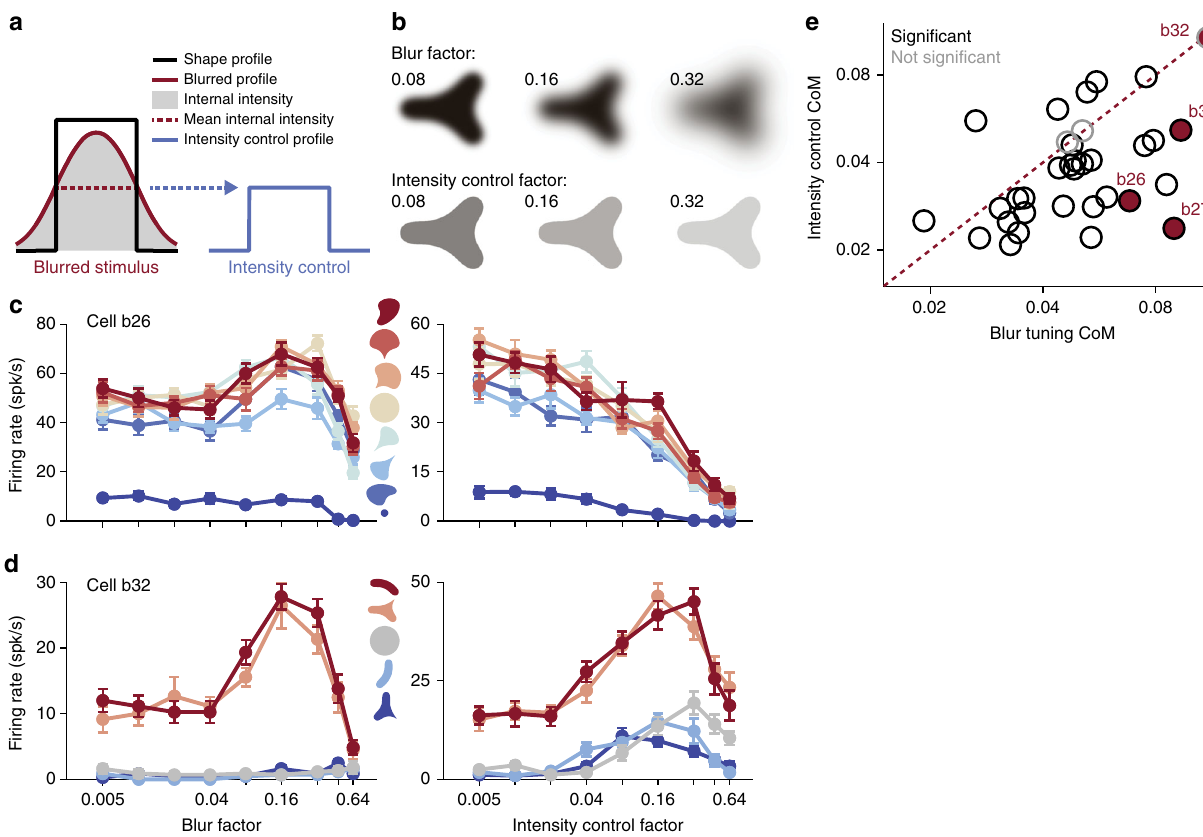
Fig. 5 Stimulus contrast does not explain blur selectivity. a Pro fi le schematic of how a blurred stimulus (red) has a decreased mean foreground intensity relative to a sharp ( β = 0.005) stimulus (black). Low/high values correspond to background/foreground image intensities, respectively. An intensity control is constructed from a sharp shape with an identical mean foreground intensity (blue). b Example blurred stimulus and intensity-matched controls. Stimuli are shown in black but were presented at either positive or negative luminance contrast. c , d Responses of preferred (red) to non-preferred (blue) shapes that were presented either blurred (left) or as intensity-matched controls (right). While blur and contrast control tuning curves are remarkably different in c , they are quite similar in d . e Center-of-Mass analysis (see Methods: ‘ Analysis and model fi tting ’ ) reveals that for a majority of cells ( n = 31 of 34) blur and contrast-control tuning curves have signi fi cantly different (black) tuning pro fi les ( t -test, p < 0.05); other cells (gray) exhibited blur and contrast-control tuning curves with CoM values that were not signi fi cantly different. For these neurons, blur tuning may be explained in the context of intensity tuning. Neurons above the diagonal typically exhibited a tuning preference for intermediate intensities while remaining largely invariant to all but the highest levels of blur; a more conservative estimate that discounts these cells ( n = 6, ≈ 18%) still fi nds the majority of neurons unexplained by tuning for stimulus contrast ( n = 25, ≈